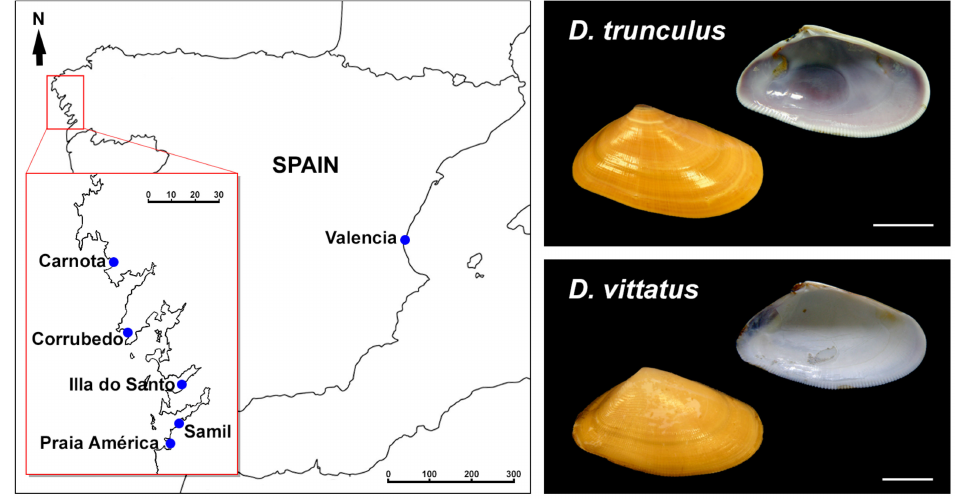
Figure 1. Collection localities and pictures of representative Donax trunculus and Donax vittatus